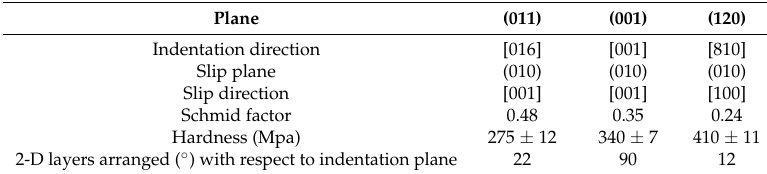
Table 1. Schmid factors of various slip systems for different planes of BF 2 AVB form I crystals [91].